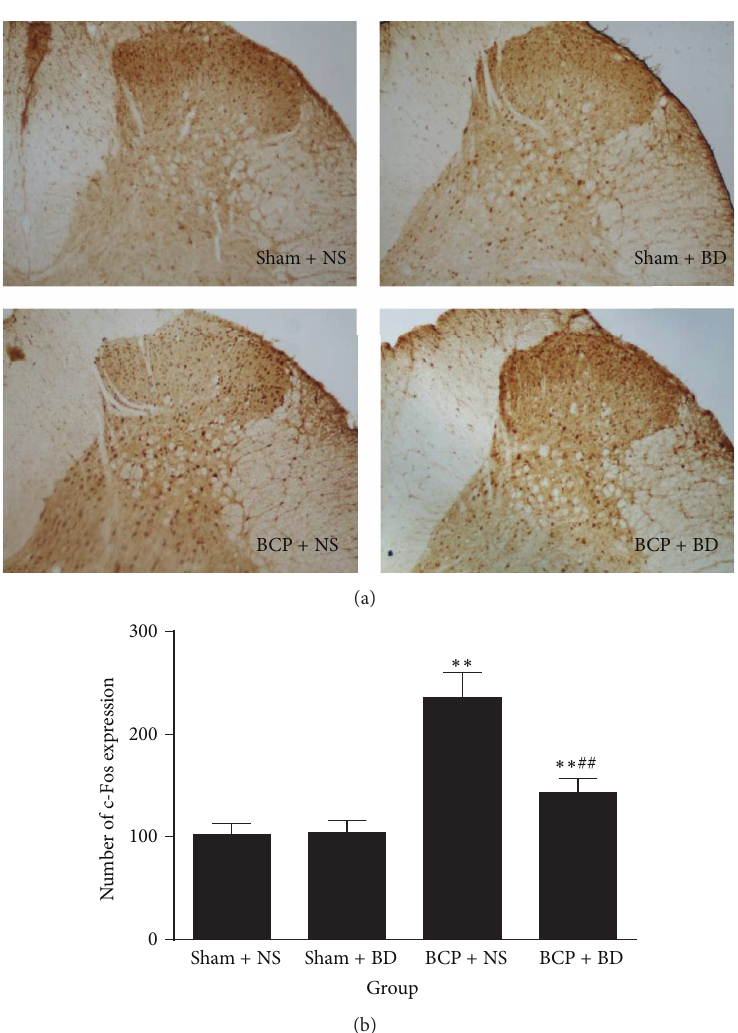
Figure 4: Intrathecal administration of BD1047 suppressed the upregulation of c-Fos protein expression. (a) Compared with sham rats, the c-Fos expression was strikingly increased in BCP rats in the ipsilateral spinal cord on day 7. Intrathecal injection of BD1047 provided a significant decrease of the c-Fos in BCP rats compared with NS-treated BCP group. (b) Quantification of c-Fos level in the dorsal horn ( 𝑛 = 4 ). Results are given as means ± SEM. ∗ 𝑃 < 0.05 , ∗∗ 𝑃 < 0.01 versus sham + NS group; # 𝑃 < 0.05 , ## 𝑃 < 0.01 versus BCP + NS group. Magnification: